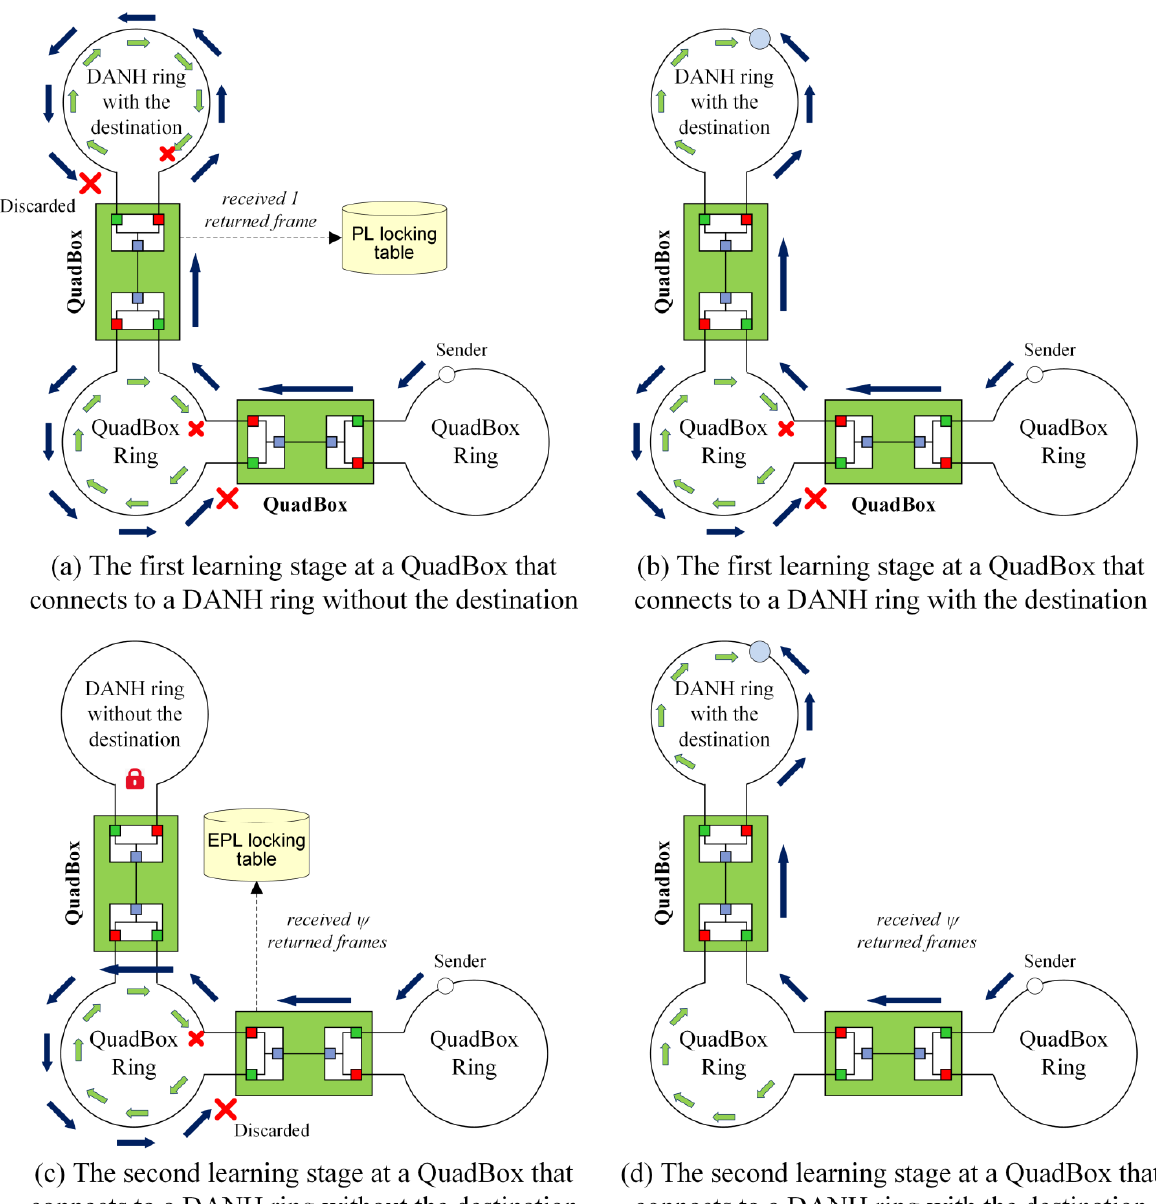
Figure 8. The two learning stages in the EPL